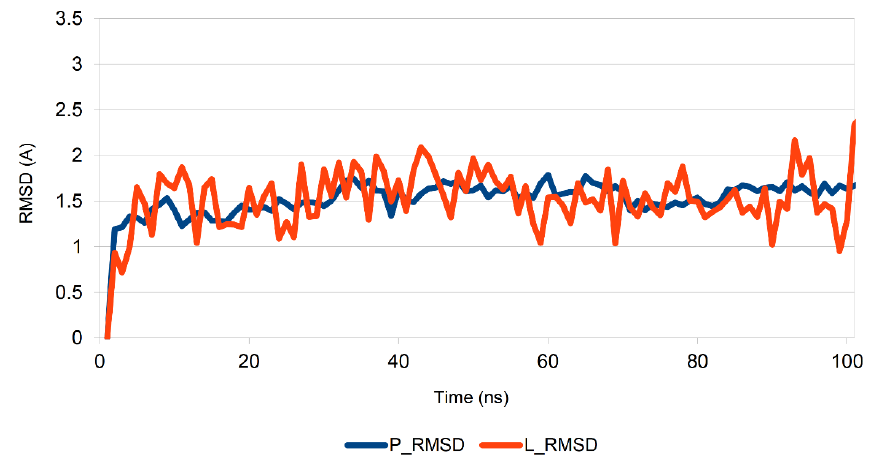
Figure 15. Protein and ligand RMSD plots of the complex (ACE2-Z3969355209).